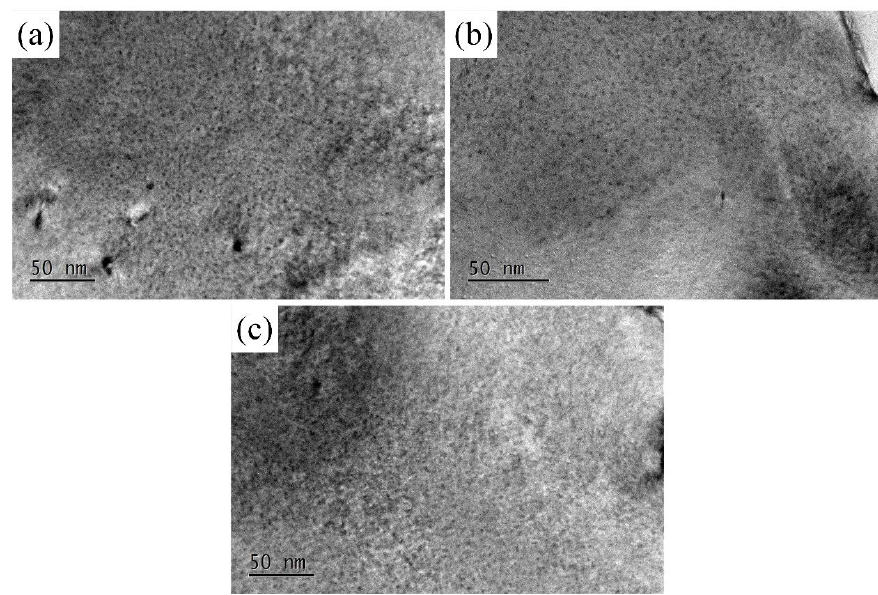
Figure 12. TEM images of matrix precipitate morphology in 7N01 aluminum alloy after different heat treatment conditions. ( a ) Base metal; ( b ) 300 °C and ( c ) 350 °C.